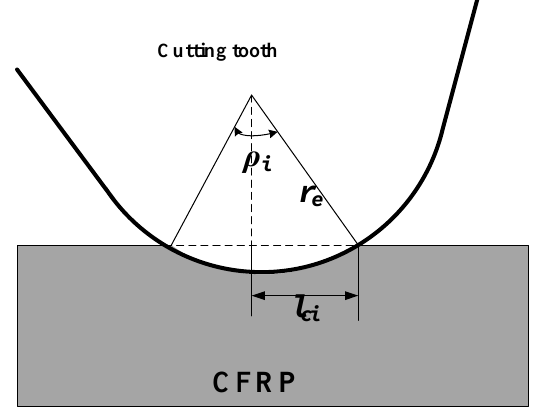
Figure 11. The schematic diagram of cutter tooth segmentation.